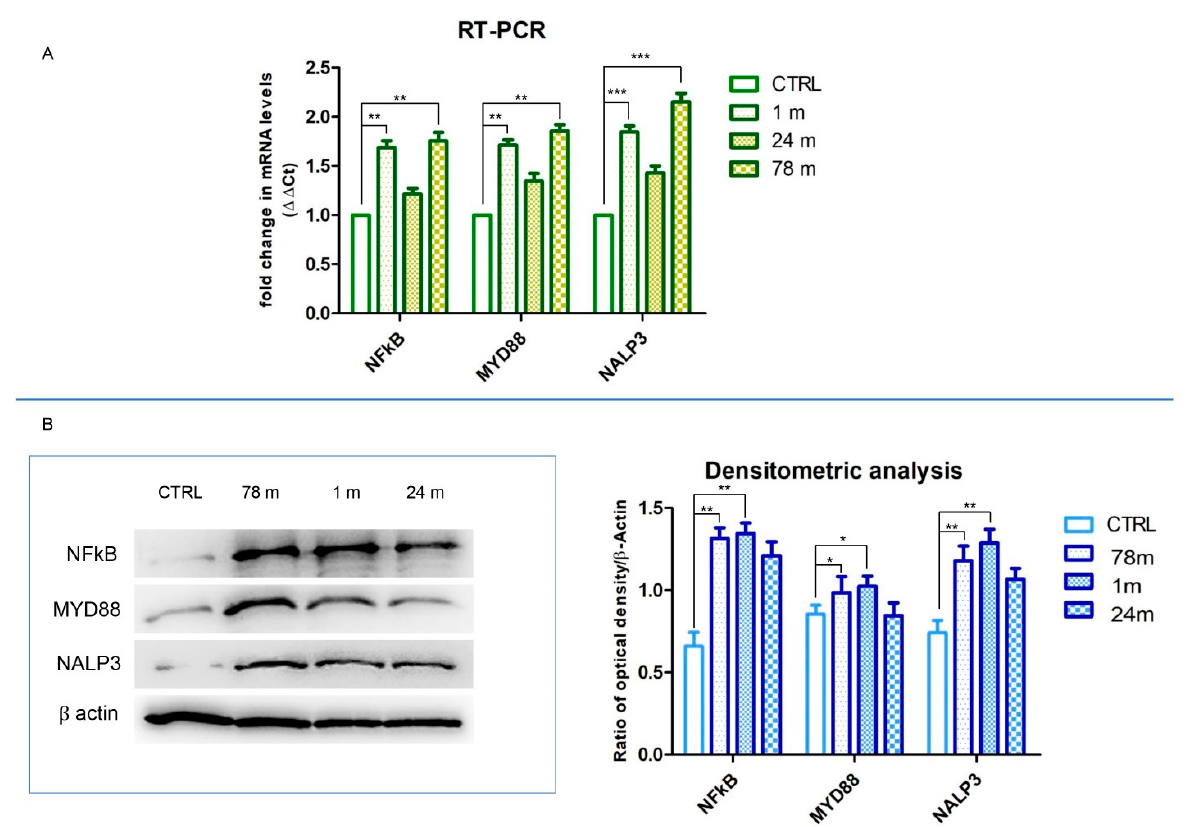
Figure 7. ( A ) Gene expression of NFkB, MyD88 and NLRP3. ( B ) Western blot analyses of NFkB, MyD88 and NLRP3 and relative densitometric analyses. * p < 0.05; ** p < 0.01; *** p < 0.001.